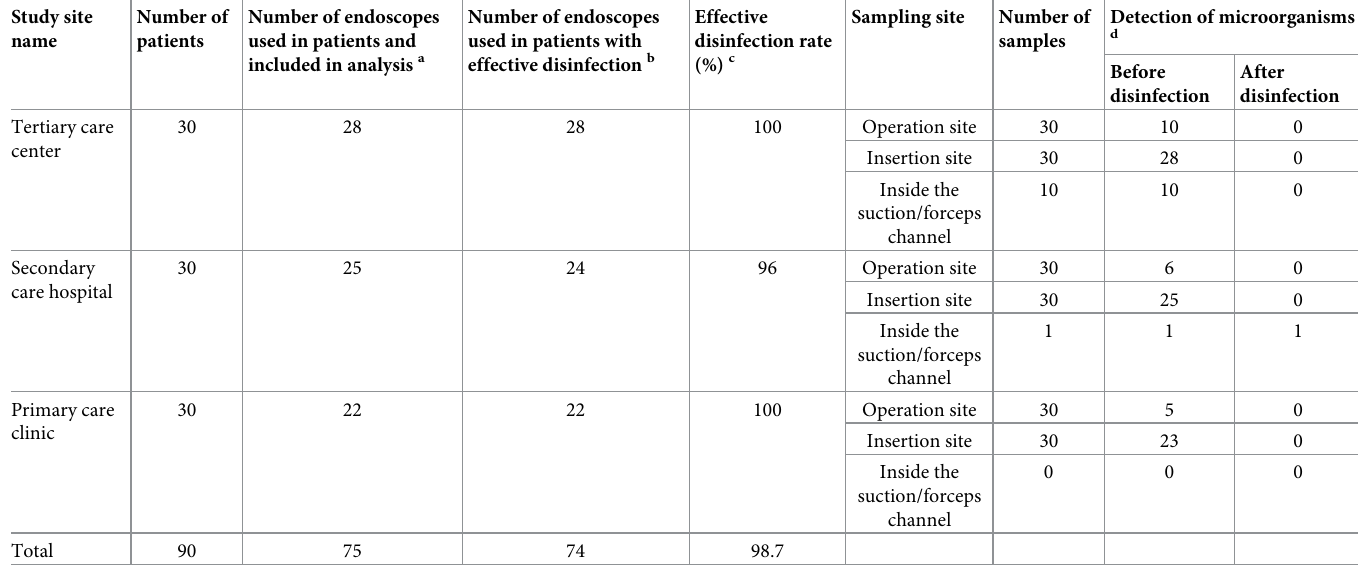
Table 2. Characteristics of patients and endoscopes included in this